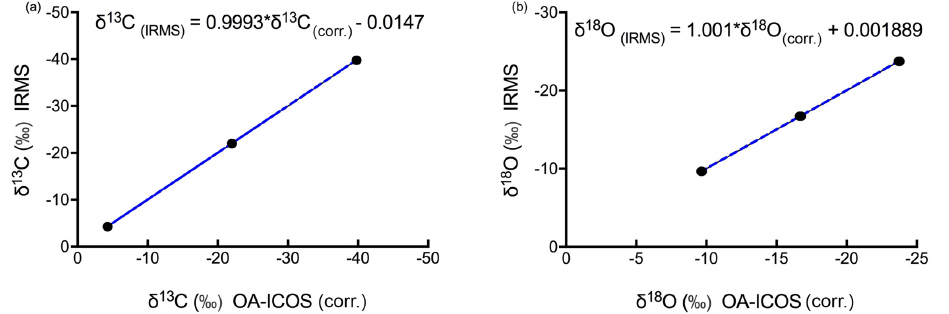
Figure 7. Three-point calibration lines for (a) δ 13 C and (b) δ 18 O measurements using OA-ICOS with 95% confidence interval.